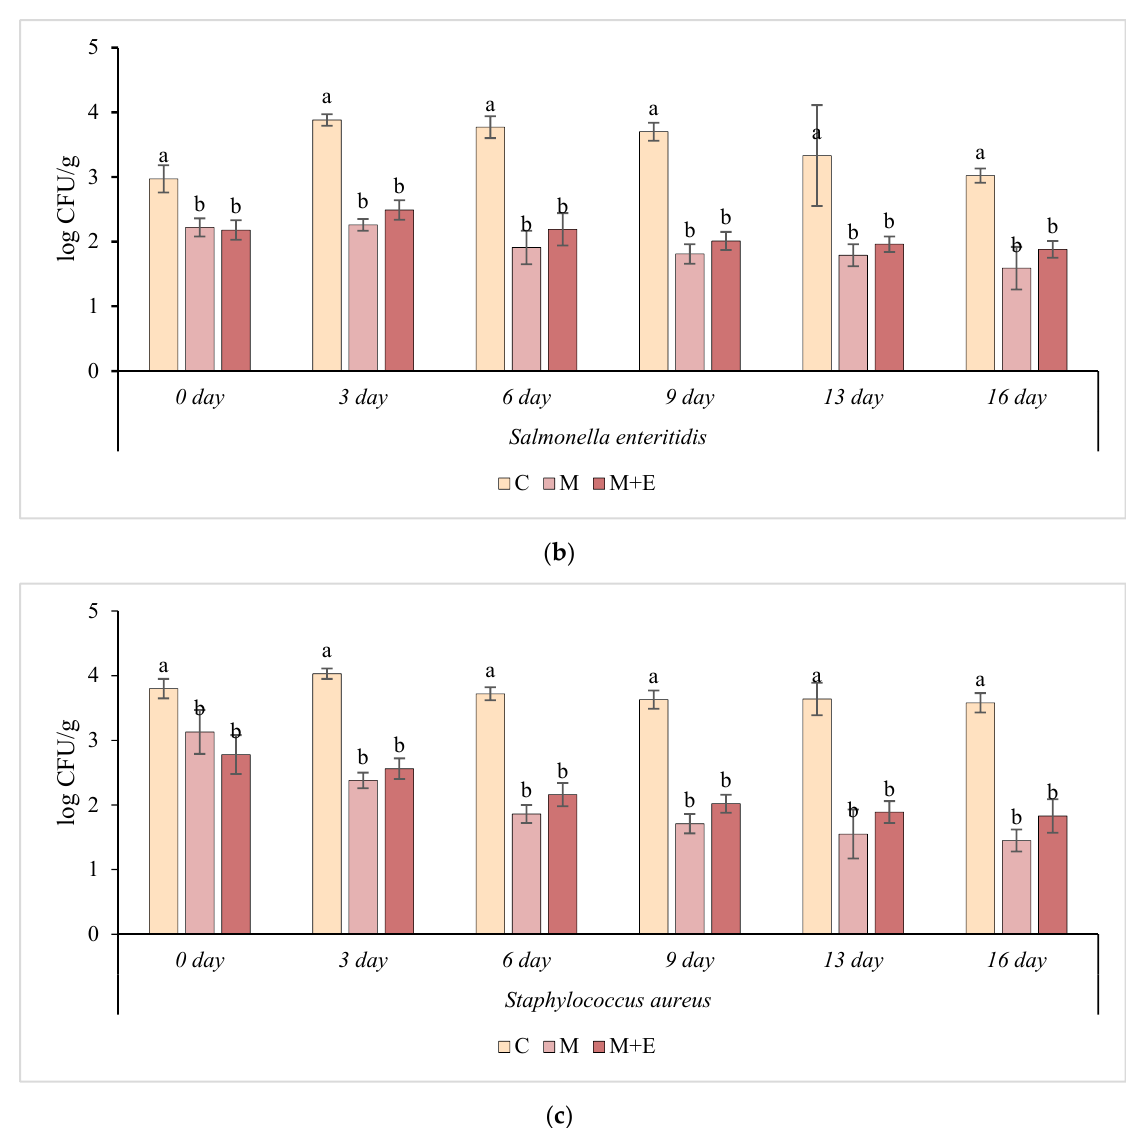
Figure 8. Cell load (log CFU/g ± SD), during refrigerated storage, of Listeria monocytogenes ( a ), Salmonella enteritidis ( b ), and Staphylococcus aureus ( c ). in different pork loin samples: Control (C), Marinated (M), marinated with essential oils (M + E). Data represent means ± SD. a, b, c = for each microorganism, at the same time of storage, average values lacking a common letter significantly differ among the same sampling time ( p < 0.05).